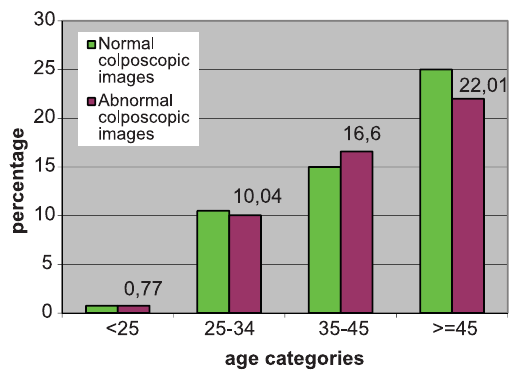
FIGURE 3. Colposcopic fi ndings. Abnormal colposcopic im- age is seen most frequently in elderly patients, but there is no signi fi cant differences by age groups (Pearson Chi-Square,